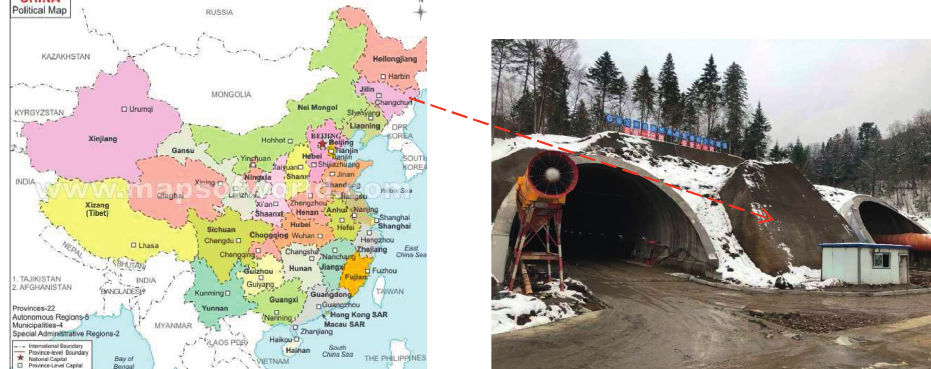
Figure 3: Tunnel and surrounding rock.